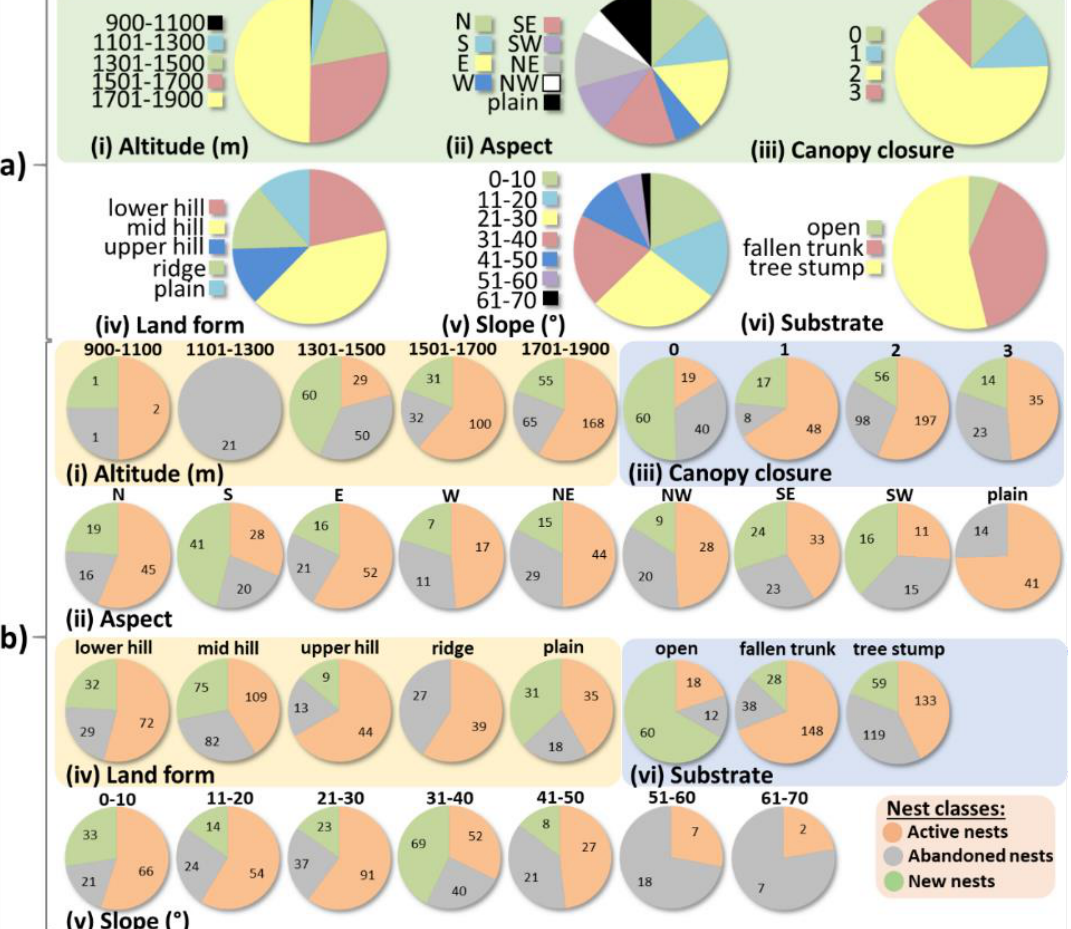
Figure 3. Distribution of Formica rufa nests according to di ff erent parameters studied. ( a ) Relative abundance of nests in di ff erent altitude ( a-i ), aspect ( a-ii ), canopy closure level ( a-iii ), landform ( a-iv ), slope ( a-v ), and substrate ( a-vi ) classes. ( b ) Active, abandoned, and new nest percentages in di ff erent altitude ( b-i ), aspect ( b-ii ), canopy closure level ( b-iii ), landform ( b-iv ), slope ( b-v ), and substrate ( b-vi ) classes. The numbers in the pie charts correspond to the number of nests in each nest class.